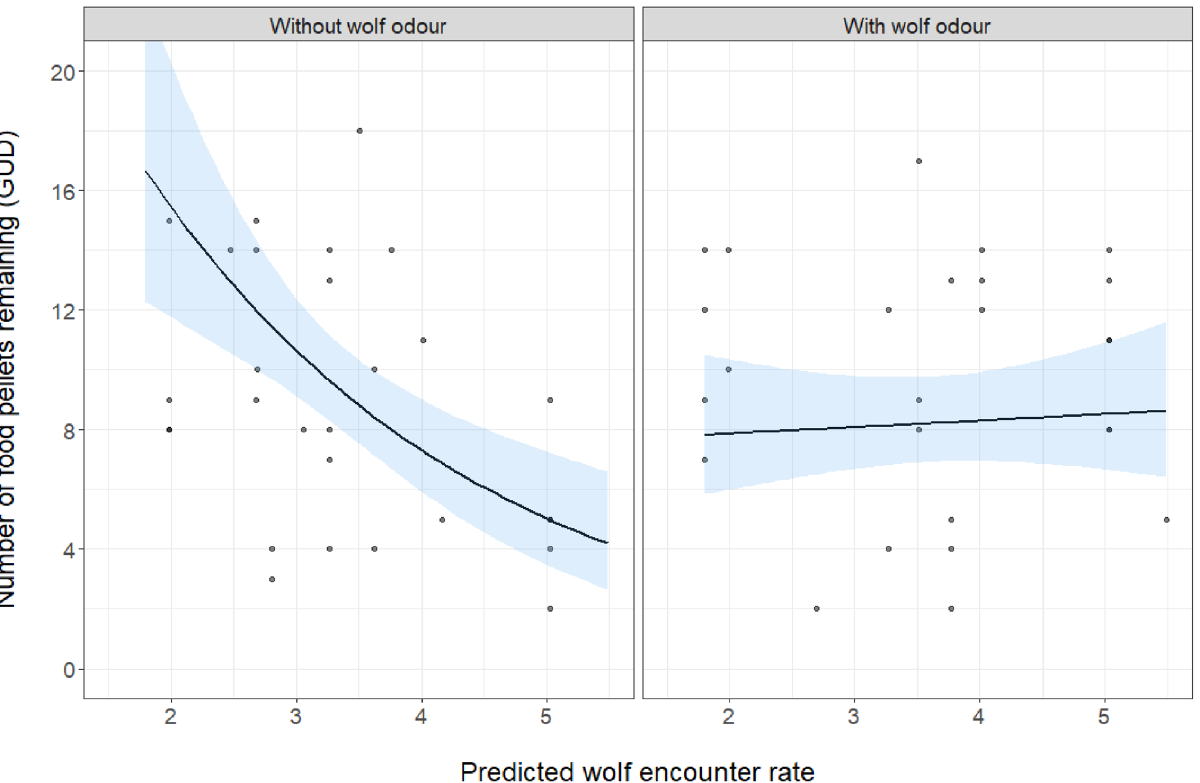
Figure 3. Predicted GUDs relative to wolf encounter rates for control and treatment plots based on the results of the Poisson GLMM. Ribbons represent the 95% confidence intervals around the predicted values. Points represent the raw GUDs. Wolf encounter rates refer to the pattern of space use of wolves in 500 × 500 m grid cells around the study plots (based on Bubnicki et al. 34